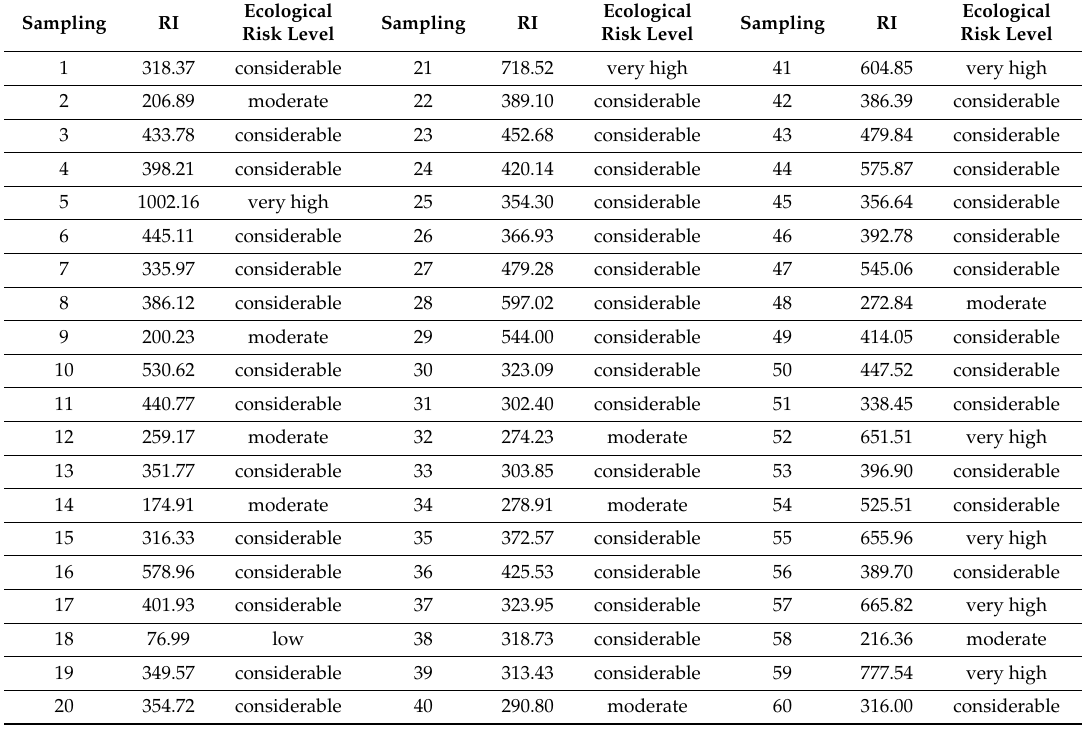
Table 8. Summary of the potential ecological risk assessment of heavy